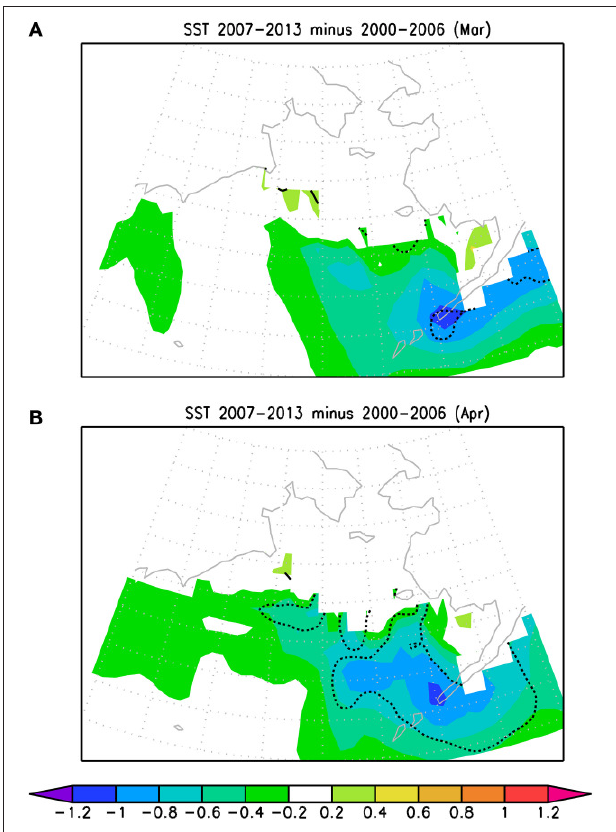
FIGURE 5 | Difference of surface turbulent heat flux (W/m 2 ) in March (A) and April (B) derived as mean during 2007–2013minus that during 2000–2006. The thick lines denote that the difference between 2007–2013 and 2000–2006 is significant at the 99% confidence level according to the Student t